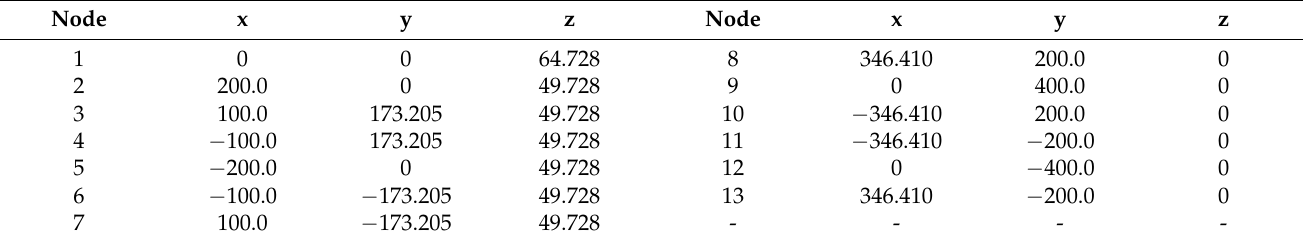
Figure 4. The reticulated dome. Table 1. Coordinates of the dome’s nodes